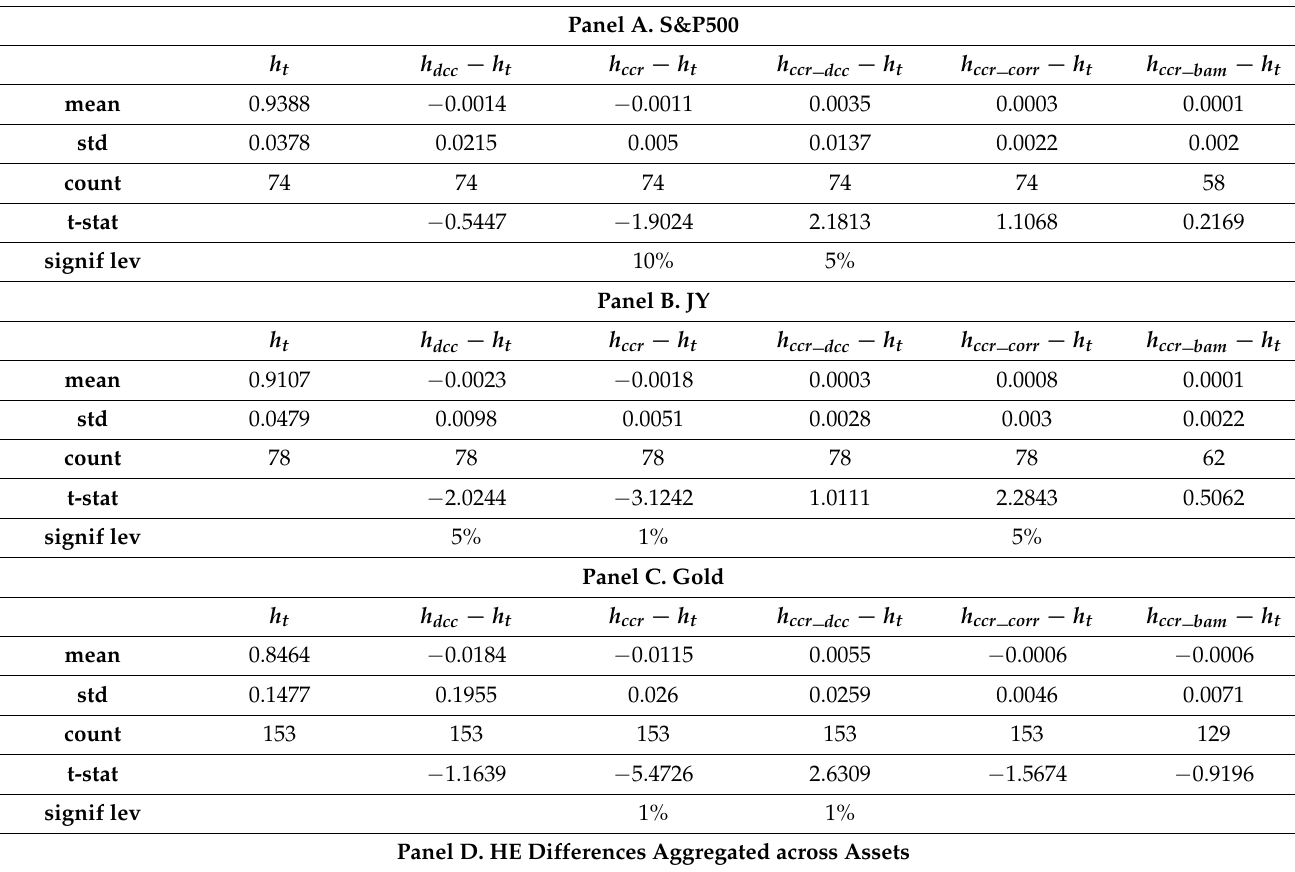
Table 2. The Benchmark HRs’ Hedge Effectiveness and Differences from them.